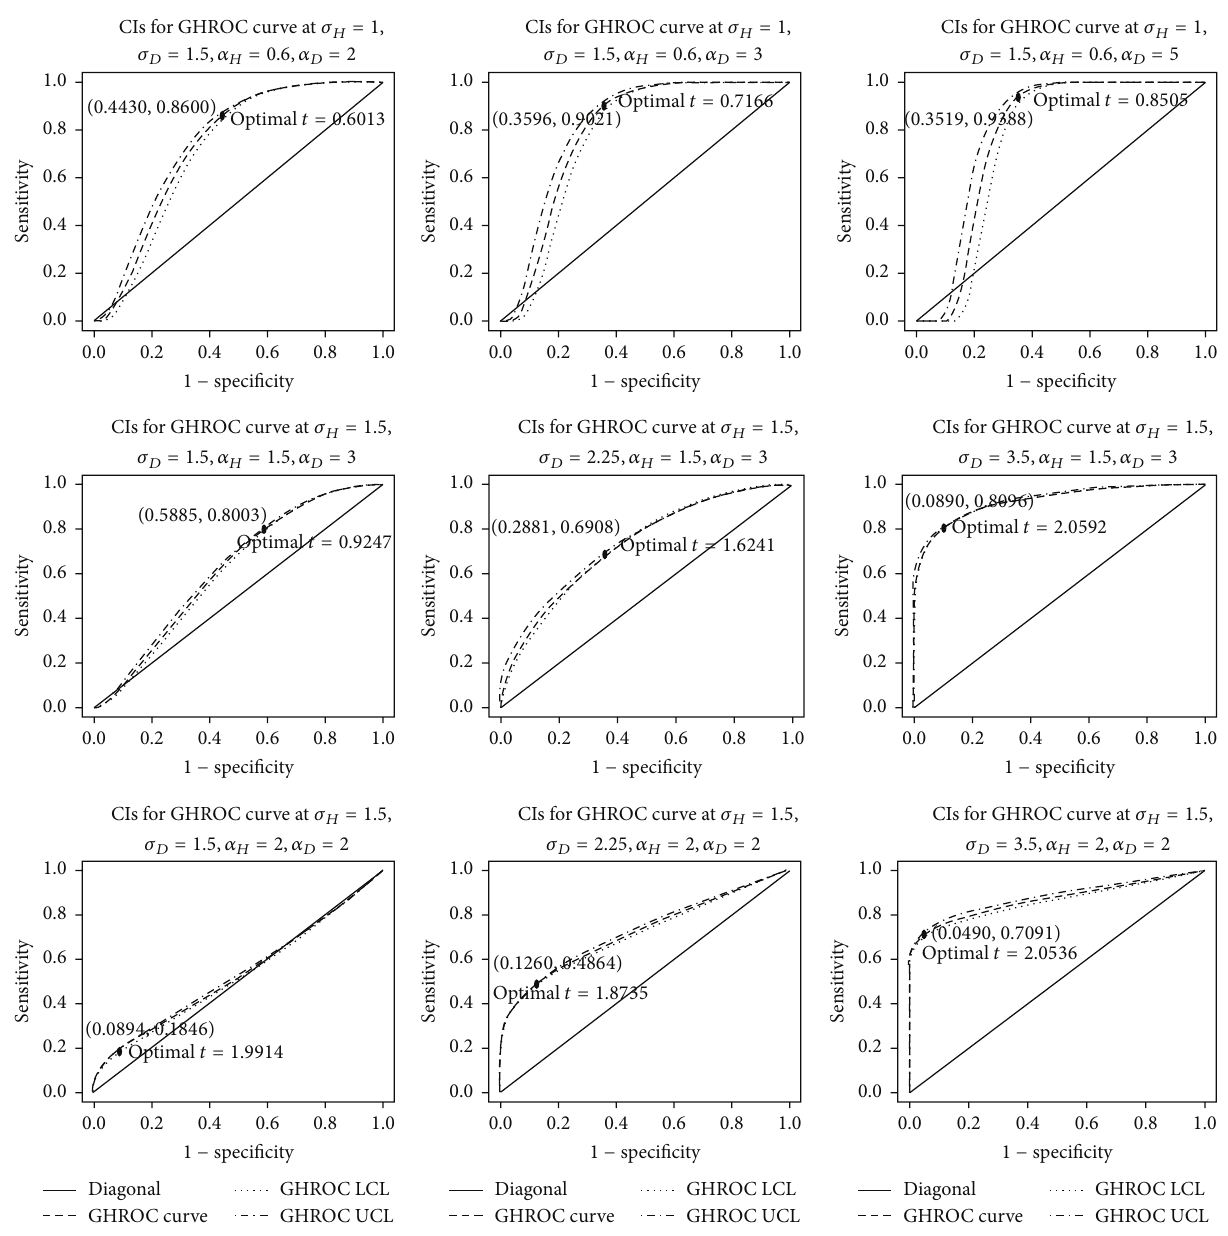
Figure 2: The confidence intervals for GHROC curve at various combinations of scale and shape parameters of both populations.